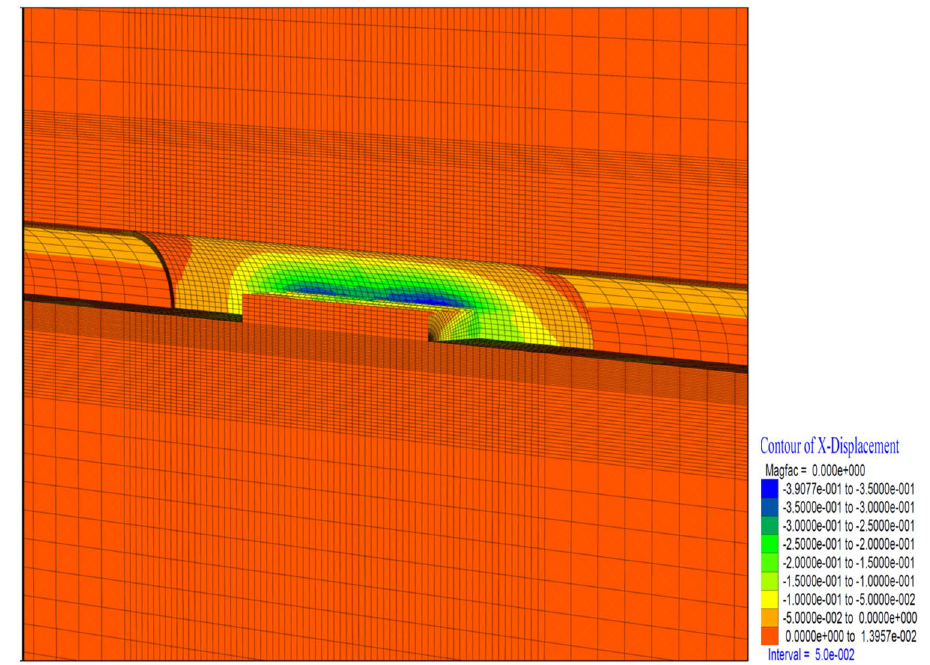
Figure 27. X displacement in stage 53.